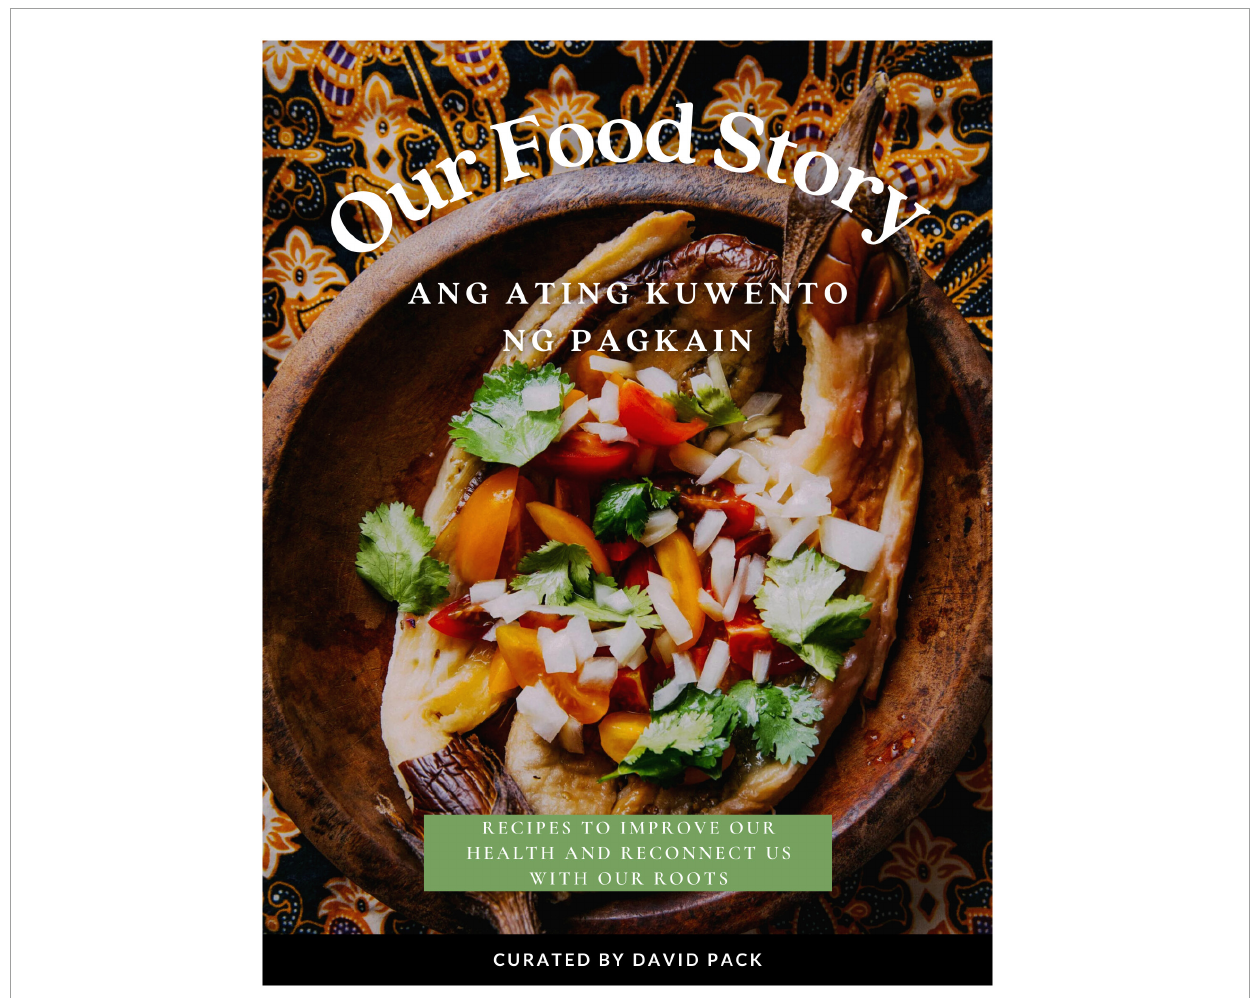
FIGURE1 Introductory page of the cookbook, containing a floral and plant-based background. Extends an invitation to readers to start their culinary journey while reading the